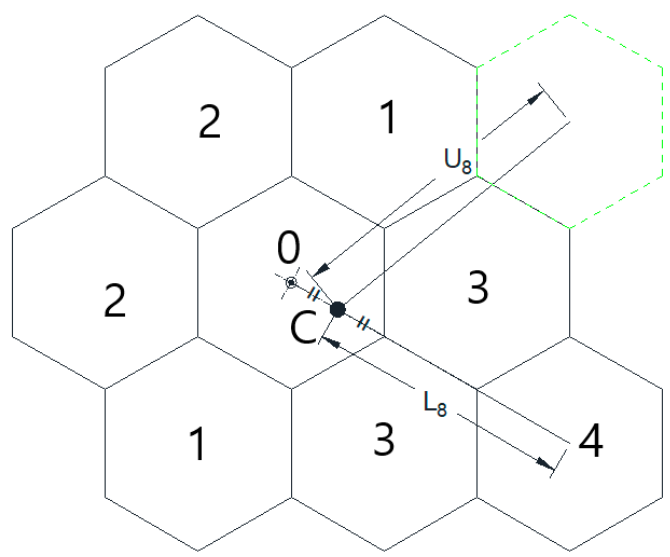
Figure 4. Center of location area, lower bound, and upper bound of reference distance ( N = 8).